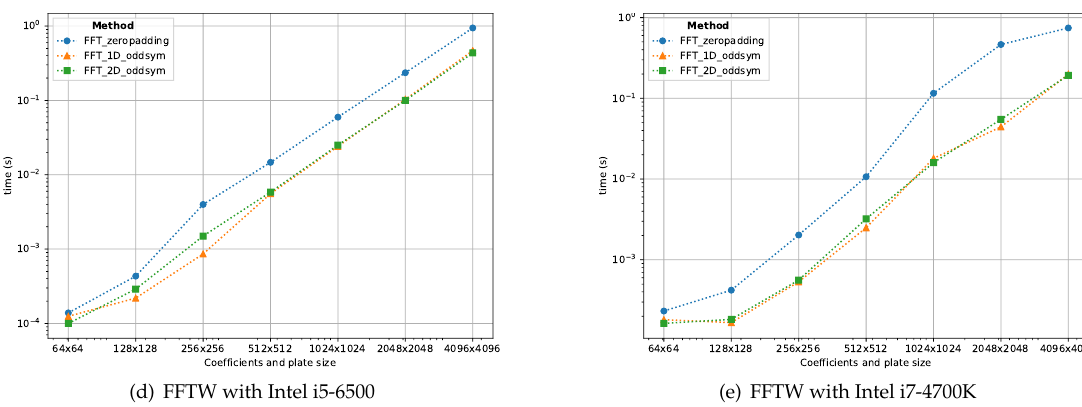
Figure 10. CPU computation times using the FFTPACK, MKL and FFTW libraries for the proposed schemes using different plate sizes. The odd symmetric schemes (1D and 2D) present the best performance overall.